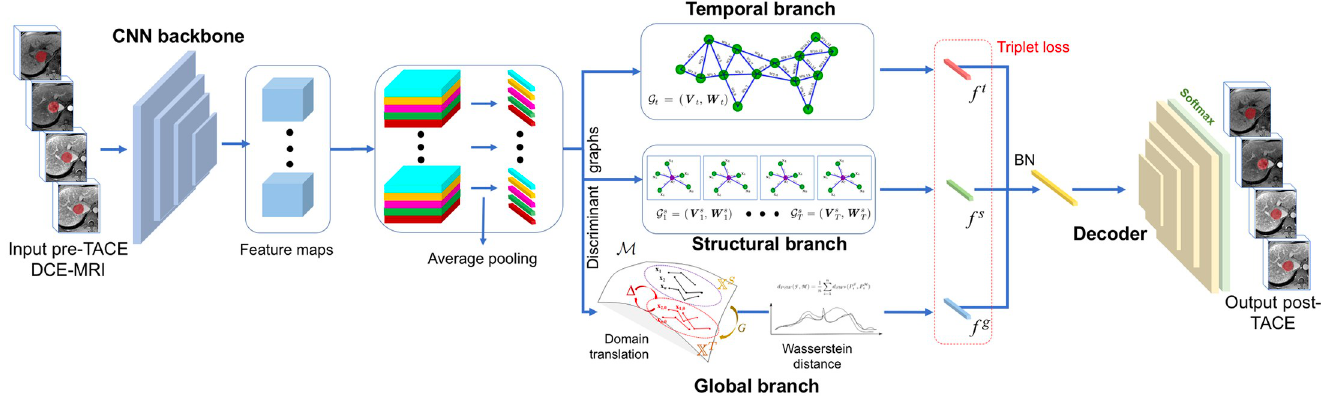
Fig 2. Future post-TACE DCE-MRI prediction framework of HCC patients. At training, feature maps are extracted from the baseline (pre-TACE) DCE-MRI sequences using a backbone ResNet, and projected in latent space, with data points partitioned within in a discriminant graph, with viable (V), equivocal (E) and nonviable (NV) tumor classes. Latent space samples are processed with three separate branches: a temporal branch modeling the dynamic changes, a structural branch capturing the morphological properties within single volumes, and global branch integrating an adversarial domain-translation loss, measuring the cost of mapping between source (pre-TACE X S ) and target (post-TACE X T ) domains in latent space M , with the three branches combined to provide complementary features for inference. At inference time, the pre-treatment DCE-MRI is processed through a BatchNorm (BN) layer and a decoder followed by a softmax layer, to generate as an output, the follow-up sequence describing HCC response to